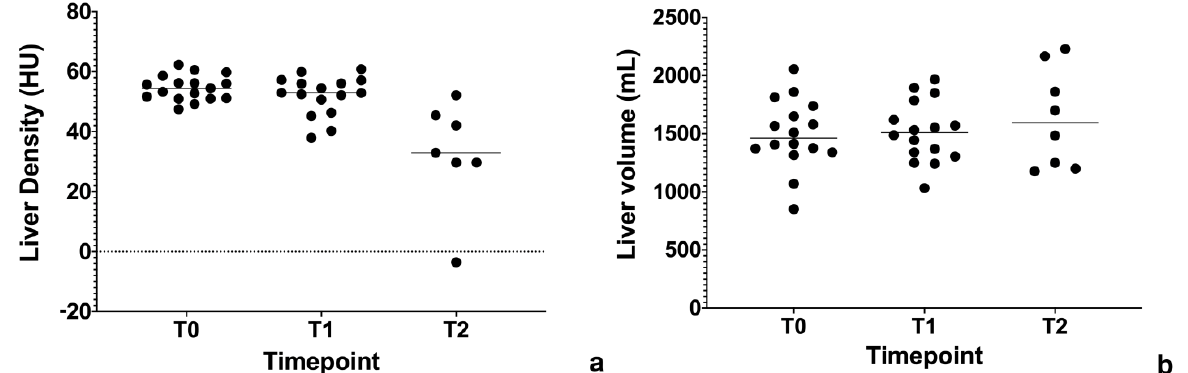
Figure 4. ( a ) Liver density (Hounsfiled Unit, HU) across timepoints. Baseline (T0, 54.54 HU), 3 months follow-up (T1, 52.02 HU), 6 months follow-up (T2, 32.62 HU). T0 vs. T1, p = 0.1958; T1 vs. T2, p = 0.0009; T0 vs. T2, p < 0.0001). ( b ) Liver volume across timepoints.